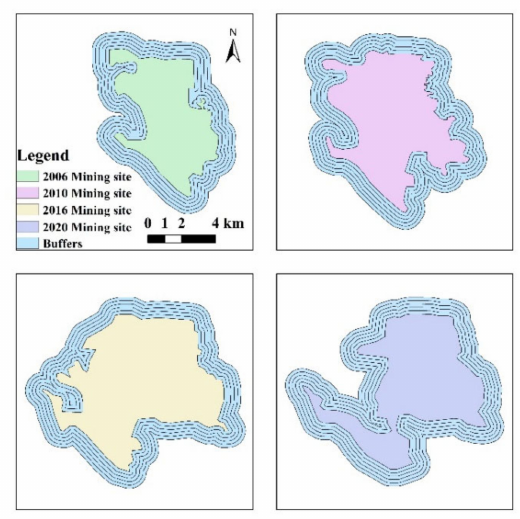
Figure 6. The mining boundary buffer zone of Antaibao opencast mine and Anjialing opencast